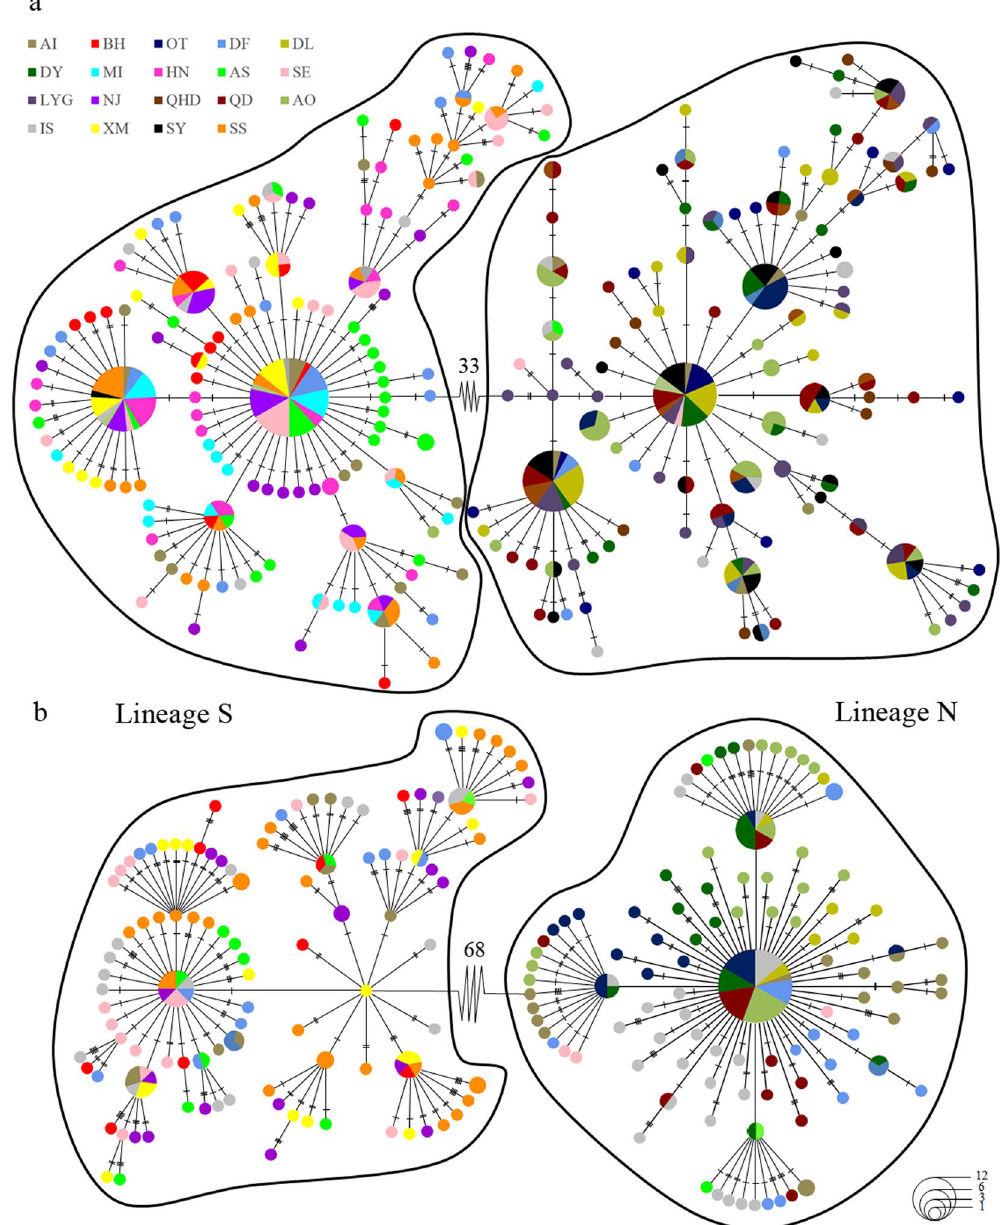
Figure 2. Minimum spanning trees constructed from mtDNA COI ( a ) and nrDNA ITS ( b ) with the sizes of circles proportionally to haplotype/ribotype frequency. The population origins of haplotypes/ribotypes are indicated by colours. Perpendicular tick marks on the lines joining haplotypes/ribotypes represent the number of nucleotide